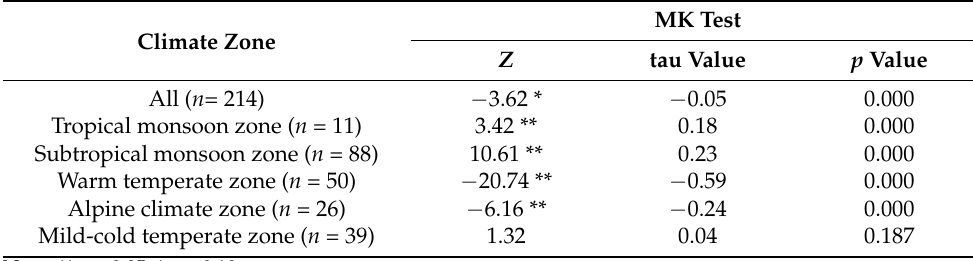
Table 3. Results of trends in TWSAs from 2004 to 2014.